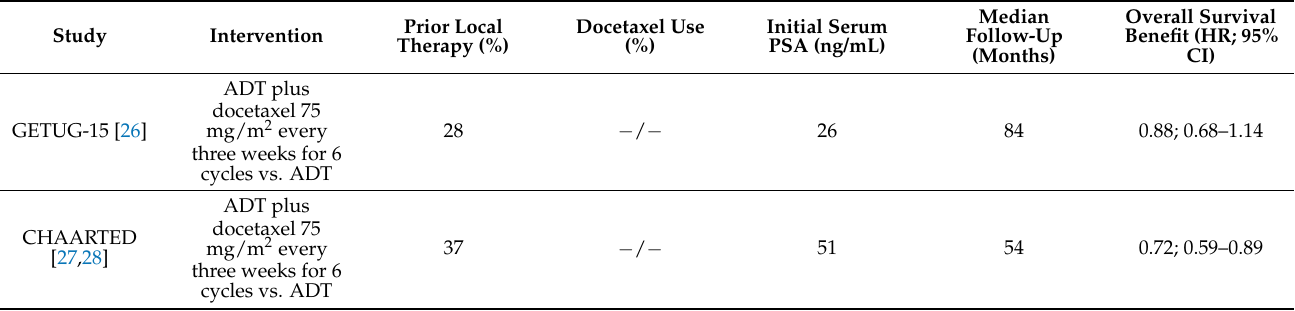
Table 1. Combination therapy studies in